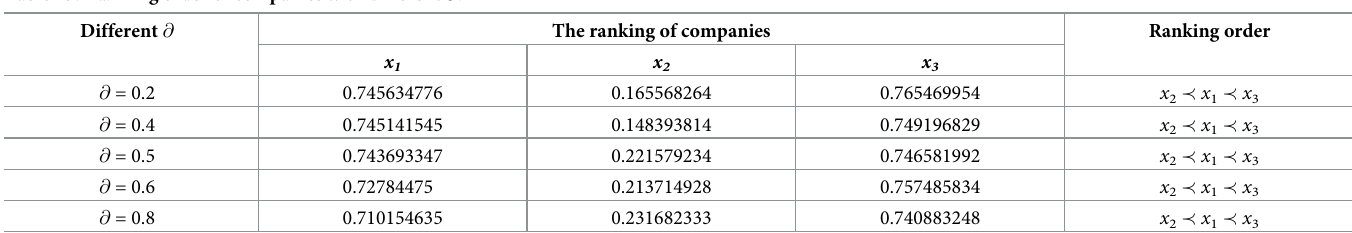
Table 13. Ranking order of companies with different @ .